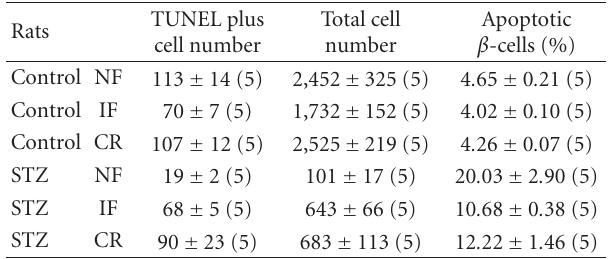
Table 7: Number and percentage of apoptotic β -cells.